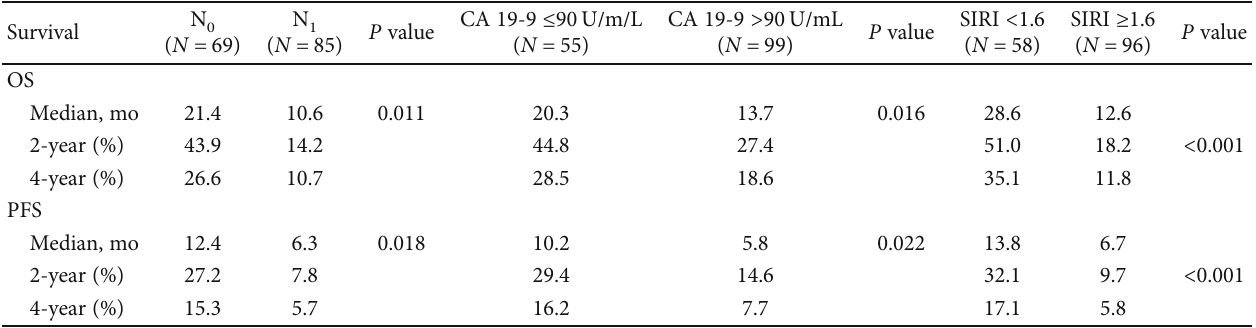
Table 3: Survival outcomes according to the factors exhibiting independent prognostic value in multivariate analyses. N 0 Survival ( N = 69